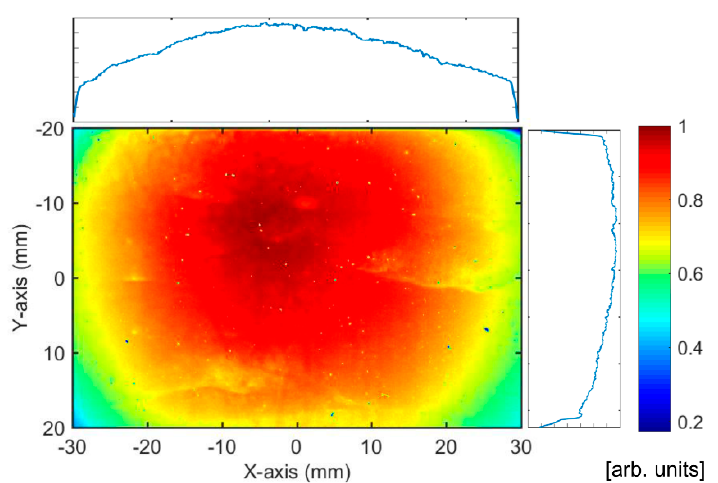
Figure 12. Measured result of pump distribution.